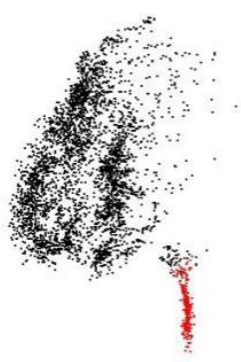
20 of 24 Figure 16. Results of tree trunk bending (the red points represent tree trunk points extracted by our method). 2) Problems oriented towards the low canopy point density. In the case of poplar tree in Figure 17, for example, the method of selecting seed points based on local elevation differences and density by Yue et al. [46] was only able to extract some of the canopy points that were less distant from the apex of the trunk due to the large spacing between the majority of canopy points and trunk points; Li et al. [47] selected seed points based on the criterion that the trunk is near the horizontal center of the crown and smaller in diameter than the crown, but poplar trees have a large offset in the center due to missing or irregularly distributed canopy points, and in this case, Li et al.'s method was unable to